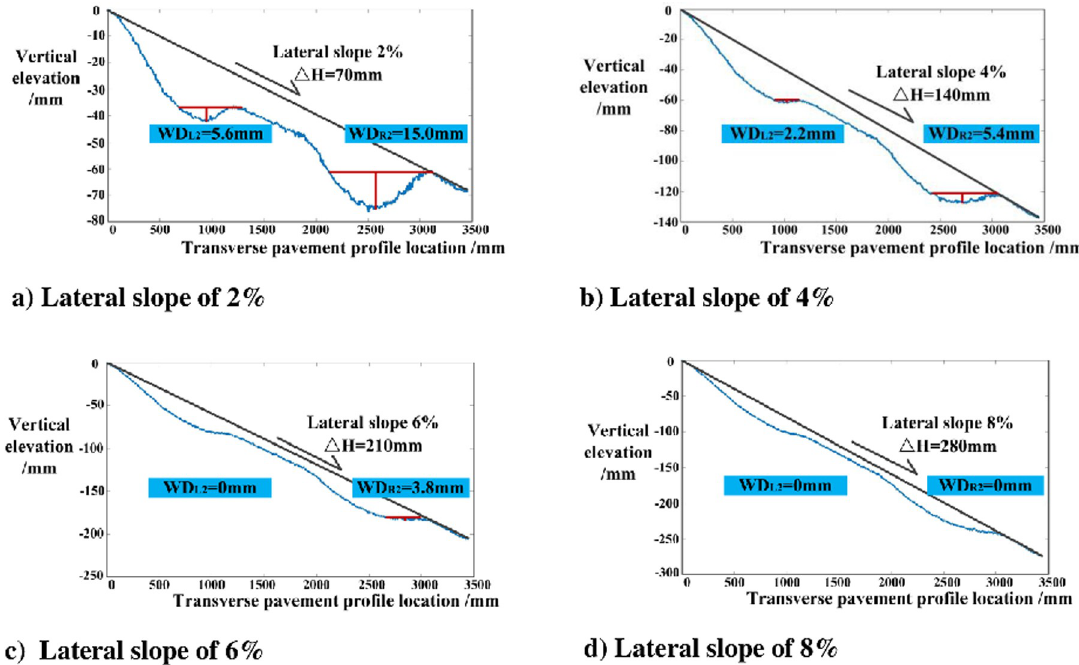
Fig 7. Variation of water-filled rut depth with lateral